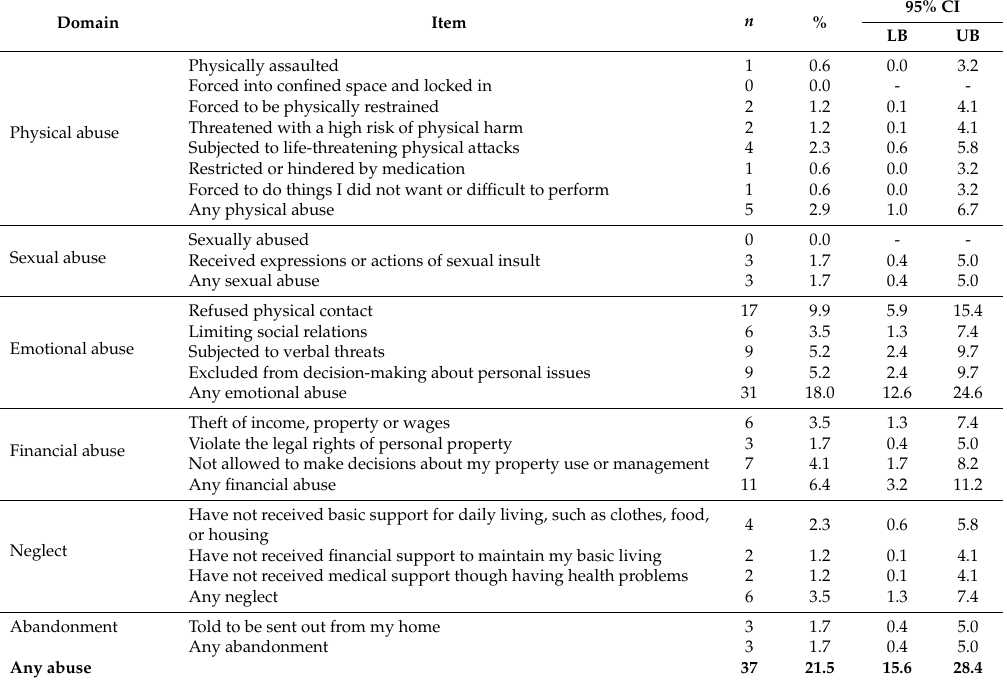
Table 2. Item-level frequencies and proportions with 95% Confidence Intervals (CIs) for elder abuse